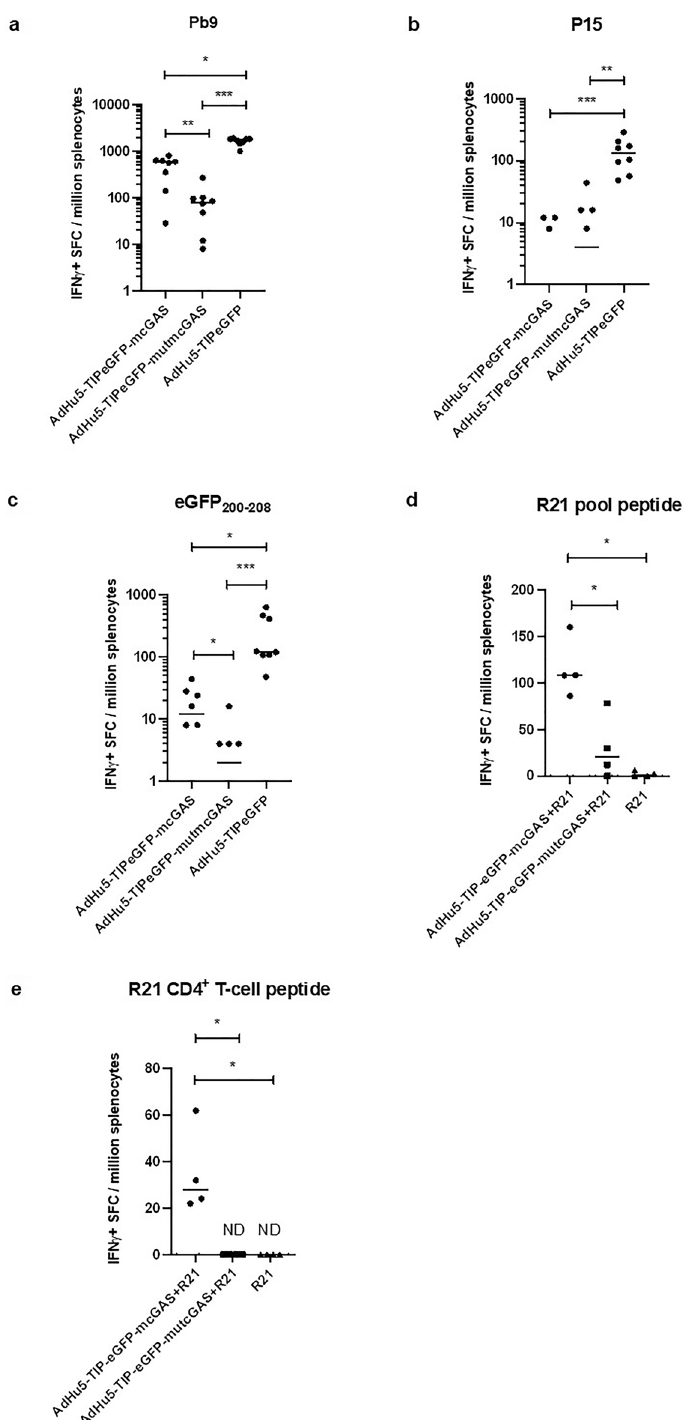
Figure 4. Immunological effects of the optimized delivery of 2 ′ 3 ′ -cGAMP. BALB/c mice ( n = 4–8 per experiment) were injected intramuscularly with 10 7 IU per mouse of AdHu5 co-expressing cGAS and transgene antigens (AdHu5eGFP-mcGAS). For panels d & e , AdHu5eGFP-mcGAS was mixed with 0.5 μg of R21 per mouse. Negative control was the AdHu5 co-expressing a mutated inactive version of cGAS (AdHu5eGFP- mut mcGAS). Immune responses were measured 14 days after vaccination using IFN-γ ELISpot. Splenocytes were re-stimulated with Pb9 ( a ), P15 ( b ), eGFP 200-208 ( c ), a T cell peptide spanning the CSP of R21 ( d ) and a CD4 + T cell peptide from the CSP of R21 ( e ). Horizontal lines in each panel represent the group medians. Statistical analysis: Kruskal–Wallis test with Dunn’s post hoc, *p < 0.05, ** p < 0.01, *** p < 0.001. For comparison of cGAS-expressing AdHu5s: Mann–Whitney test: * p < 0.05, ** p <